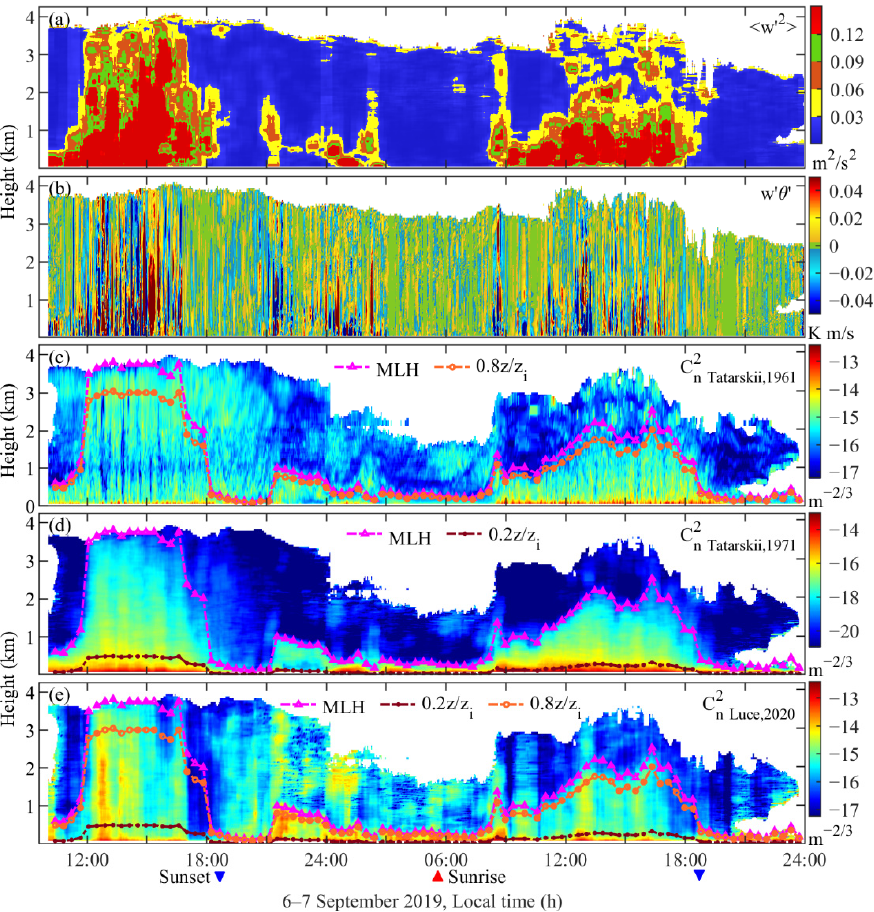
Figure 5. The results of the variances of vertical wind fluctuation ( a ), instantaneous flux of potential temperature ( b ), log 10 (cid:1829) (cid:3041)(cid:2870) estimated by (cid:1829) (cid:3041) (cid:3021)(cid:3028)(cid:3047)(cid:3028)(cid:3045)(cid:3046)(cid:3038)(cid:3036)(cid:3036),(cid:2869)(cid:2877)(cid:2874)(cid:2869)(cid:2870) ( c ), (cid:1829) (cid:3041) (cid:3021)(cid:3028)(cid:3047)(cid:3028)(cid:3045)(cid:3046)(cid:3038)(cid:3036)(cid:3036),(cid:2869)(cid:2877)(cid:2875)(cid:2869)(cid:2870) ( d ), and (cid:1829) (cid:3041) (cid:3013)(cid:3048)(cid:3030)(cid:3032),(cid:2870)(cid:2868)(cid:2870)(cid:2868)(cid:2870) ( e ) in the observations from 6 September to 7 September 2019, local time.